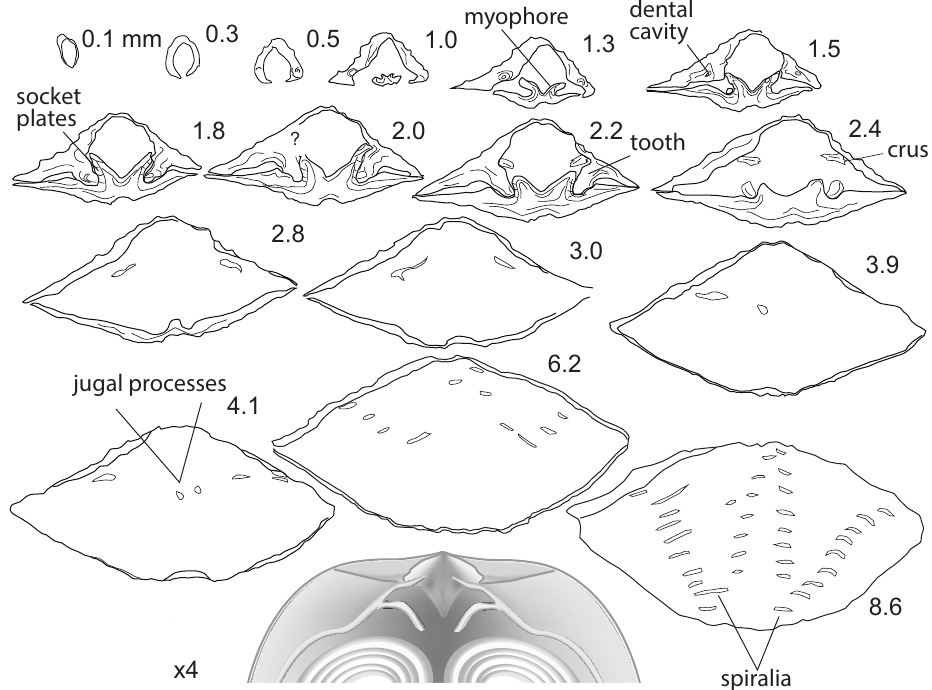
Figure 2. Eiratrypa thorslundi gen. nov. Serial sections and reconstruction of internal structures (ventral valve up) based on specimen PMO 158.043v, refigured from Baarli (2021a), figures 13 and 14, from Leangen Member, Solvik Formation, section along highway E18 at Hofstad, Asker.